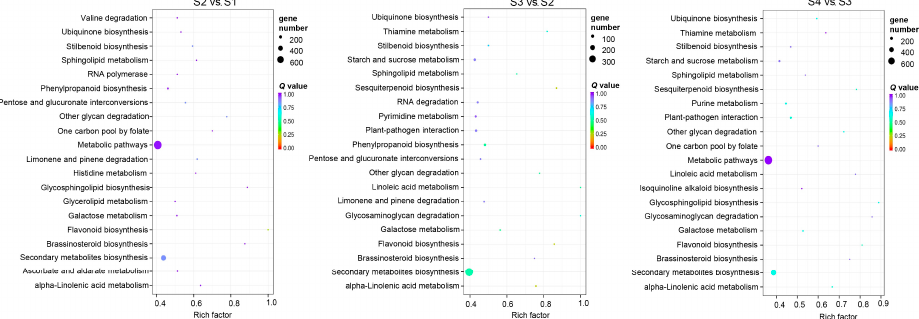
Figure 9. KEGG enrichment pathway analysis of DEMs in S2 vs. S1, S3 vs. S2, and S4 vs. S3. The top 20 KEGG pathways of DEMs are displayed.